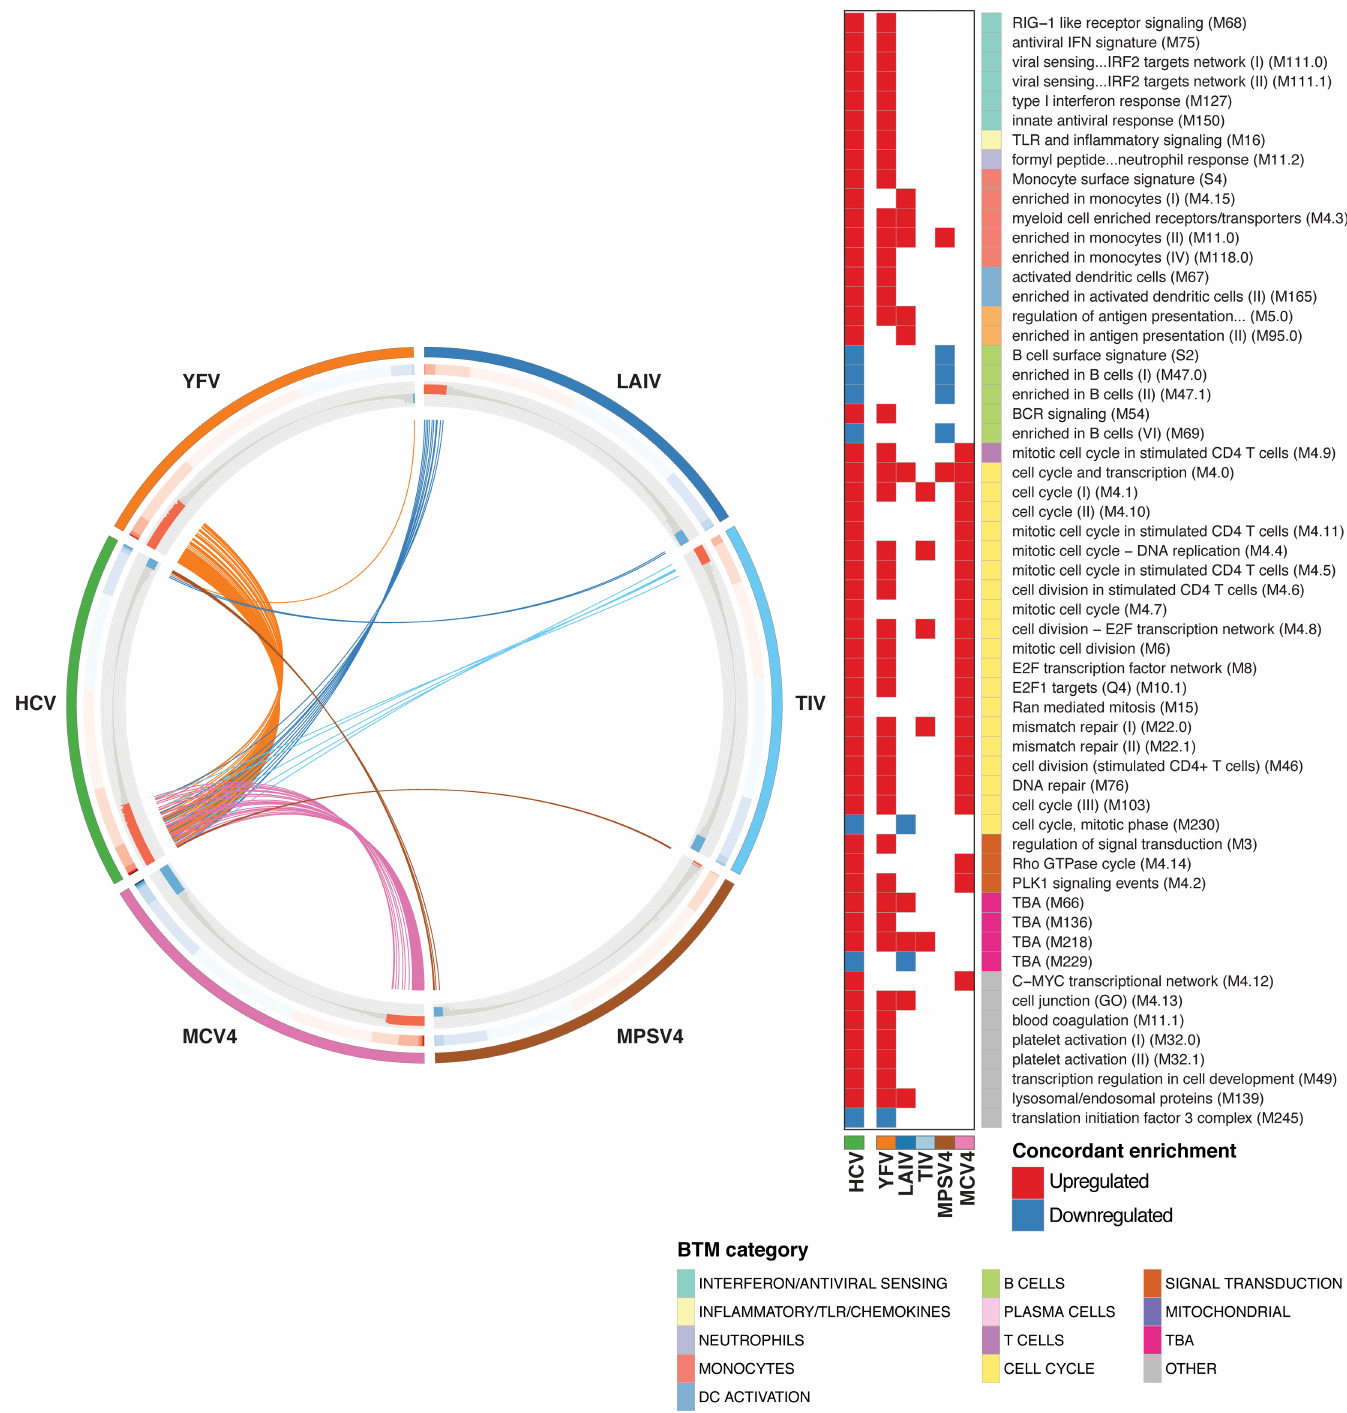
Fig 5. Comparison of immune responses to acute HCV and different vaccines. CIRCOS plot indicating BTM enrichment patterns shared between the Early acute HCV and indicated vaccine responses (day 7 post-vaccination versus pre-vaccination baseline). BTMs are ordered along each vaccine (or HCV) segment by GSEA Normalized enrichment score (NES) values in the corresponding dataset. Outer track color indicates HCV/vaccine dataset. Middle track heatmap plots NES values for each BTM. Inner track histogram plots -log 10 p-values (GSEA pre-ranked) for BTM enrichment (relative to baseline); red positive bars indicate upregulation, blue negative bars indicate downregulation. For each vaccine group, each BTM demonstrating concordant activity (i.e. enriched, same directionality) with the response to Early acute HCV (Resolution group) is linked by an arc (colored by vaccine) to the HCV segment. BTMs concordant between Early acute HCV and any vaccine dataset are listed at right. Filled cells denote concordant enrichment relative to baseline (GSEA pre-ranked q-value < 0.01); red indicates upregulation, blue indicates downregulation. BTM category indicated on color sidebar. https://doi.org/10.1371/journal.ppat.1007290.g005 PLOS Pathogens| https://doi.org/10.1371/journal.ppat.1007290 September 17,